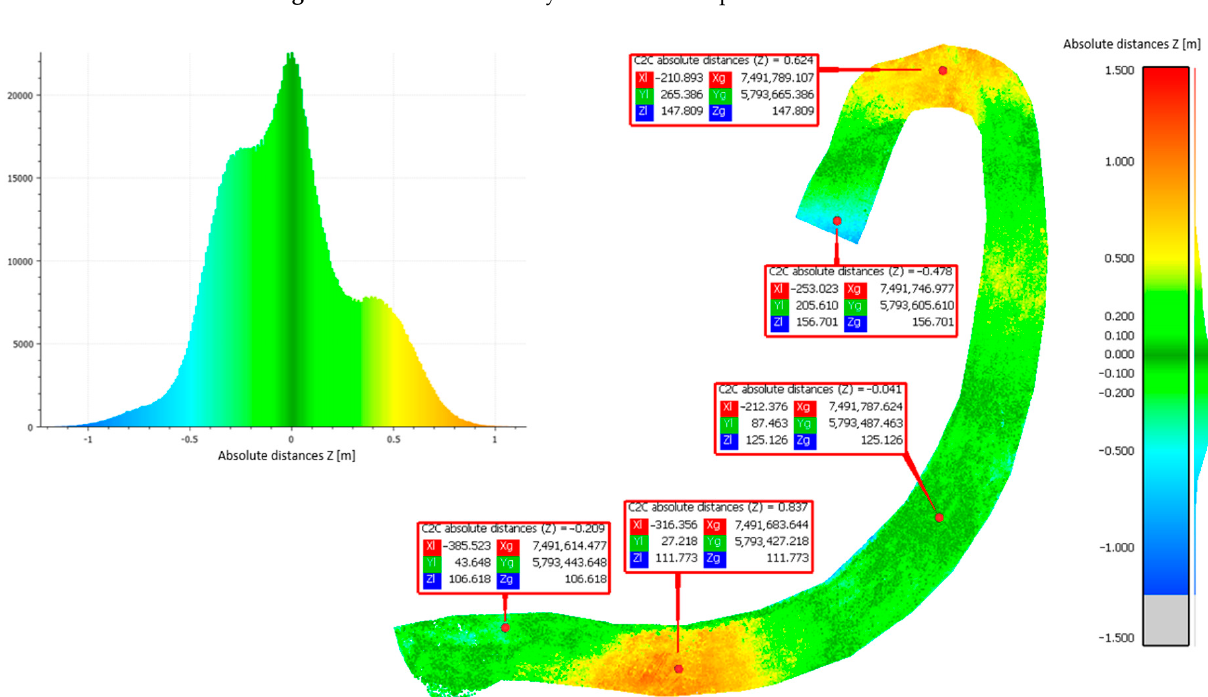
Figure 7. C2C distance analyses for set 2 compared to set 3.